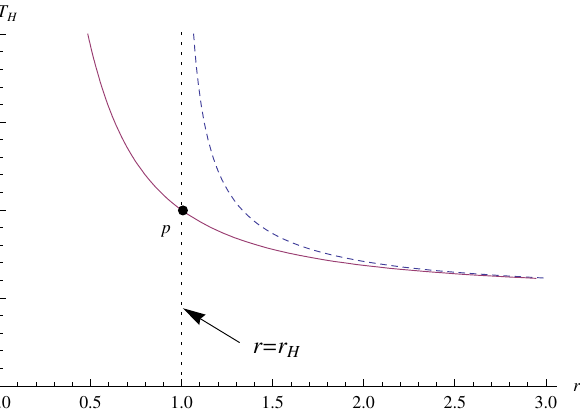
Figure 1. Freely falling temperature in a drip frame (solid line) and fiducial temperature (dashed line) in the PG coordinates in the unit of the Hawking temperature with r H = 1. For fiducial observers, freely falling temperature is seen to diverge at the event horizon. However, for freely falling observers in a drip frame, freely falling temperature is well-defined at the horizon and increased to the r = 0